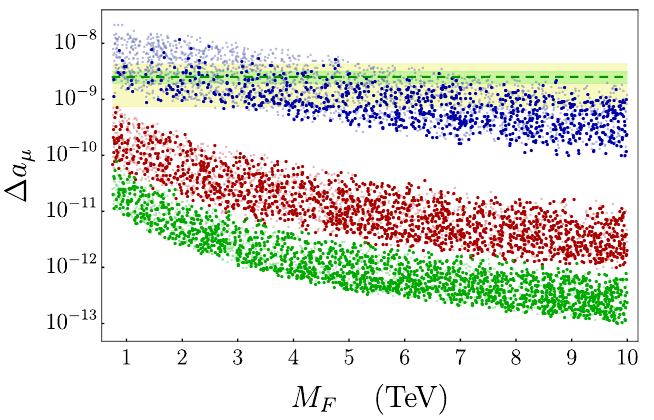
√ = 4 π (blue), ρ 2 = ( Y S ) 2